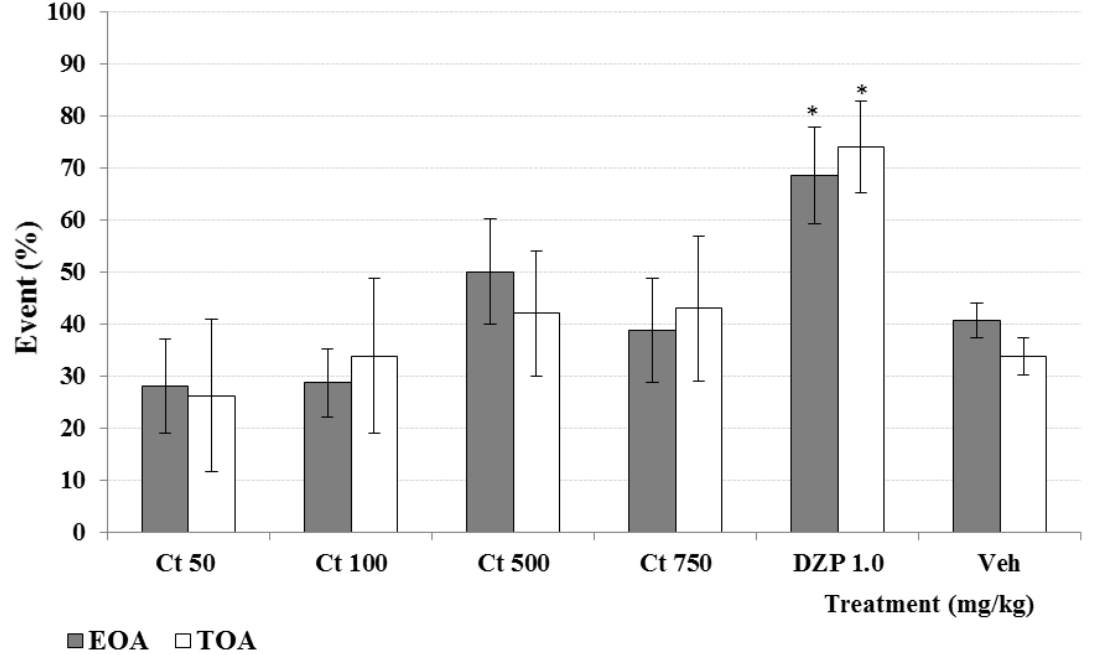
Figure 5. Effect produced by different doses (50, 100, 500 and 750 mg/kg, p.o. ) of Ct extract from C. tenuiflora (Ct) on percentage of entries (EOA) and time (TOA) spent by mice on open arms in the EPM. The results are presented as means ± SD. * p < 0.05, as compared with the control group. (ANOVA one way following by Dunnet test); n = 6 mice per group. DZP = Diazepam, Veh = Tween 20,